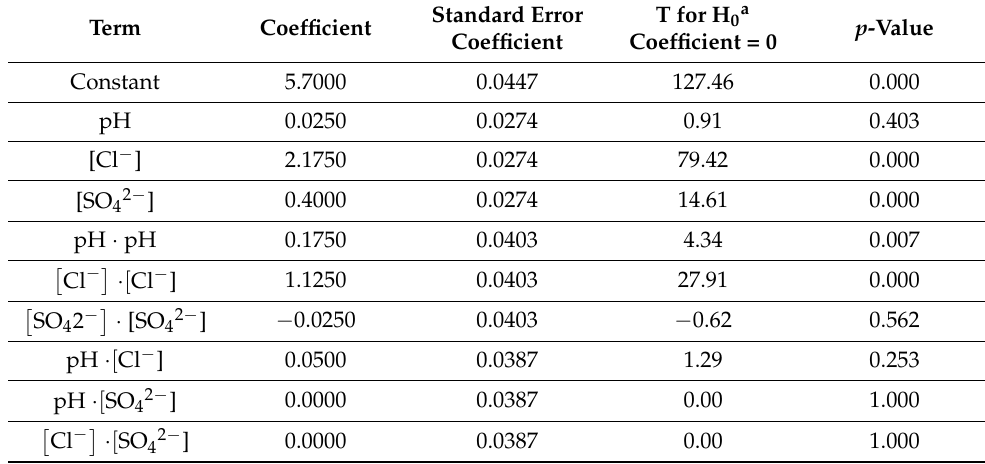
Figure 4. Pareto chart for the standardized effects of pH, chloride concentration, and sulfate concentration on the corrosion current density of carbon steel in a soil environment. Table 6. Estimated coefficients with coded units for corrosion current density ( i corr